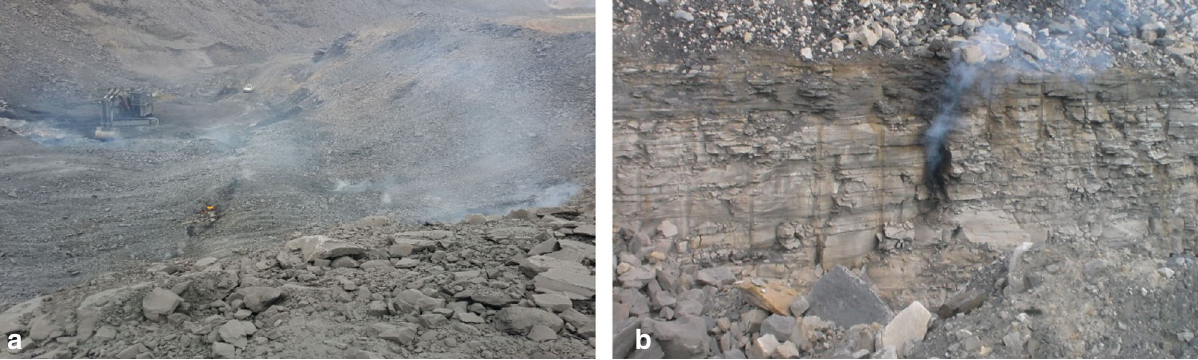
Fig. 2 a Signs of self-heating in coal seam at Khwezela Mine (Bokgoni Pit) and b self-heating of in-seam shale at Goedgevonden Colliery, Witbank, South